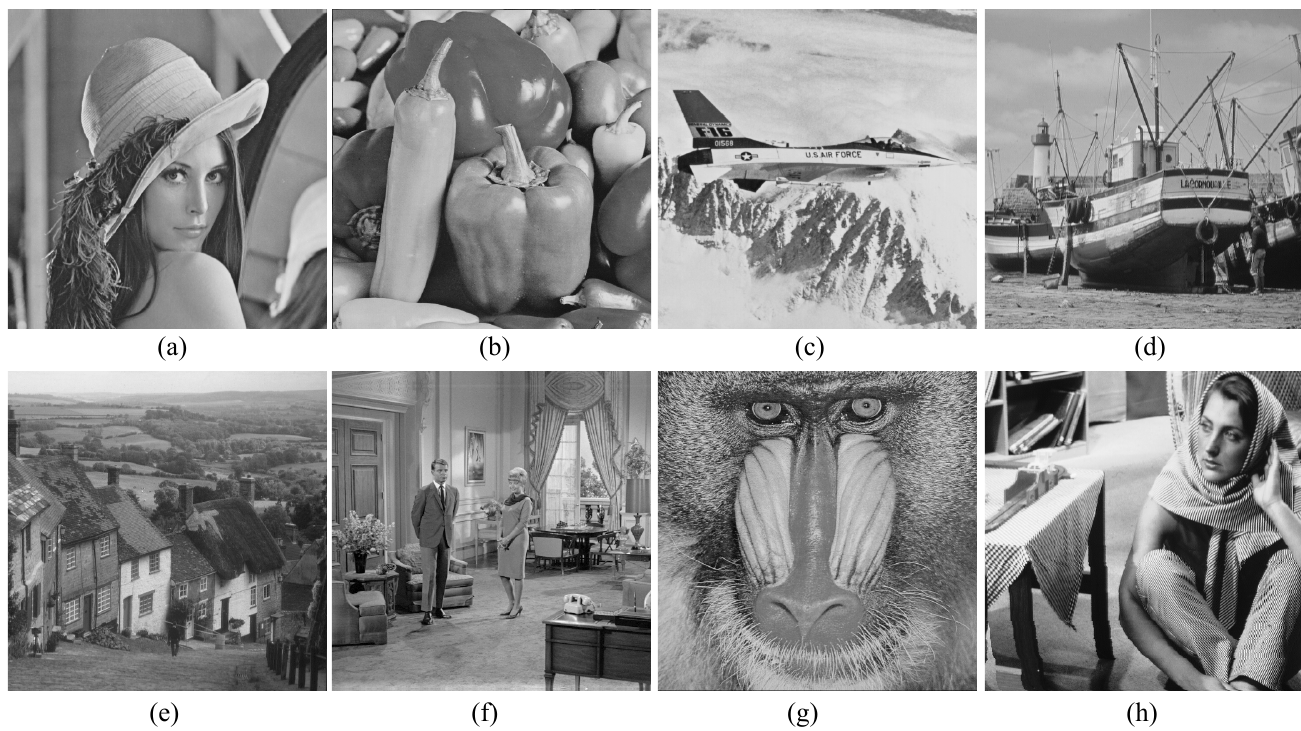
Figure 4. Test images used in our experiments: ( a ) Lena, ( b ) Pepper, ( c ) Airplane, ( d ) Boat, ( e ) Goldhill, ( f ) Couple, ( g ) Baboon and ( h )